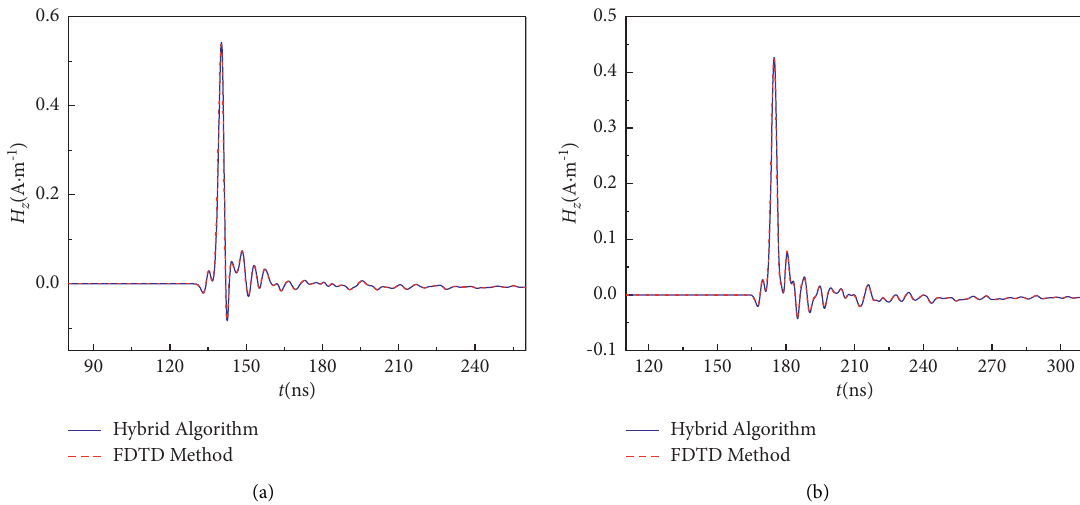
Figure 5: Near-field H z scattered from the rough surface by FDTD and by hybrid algorithms for the TE case. (a)